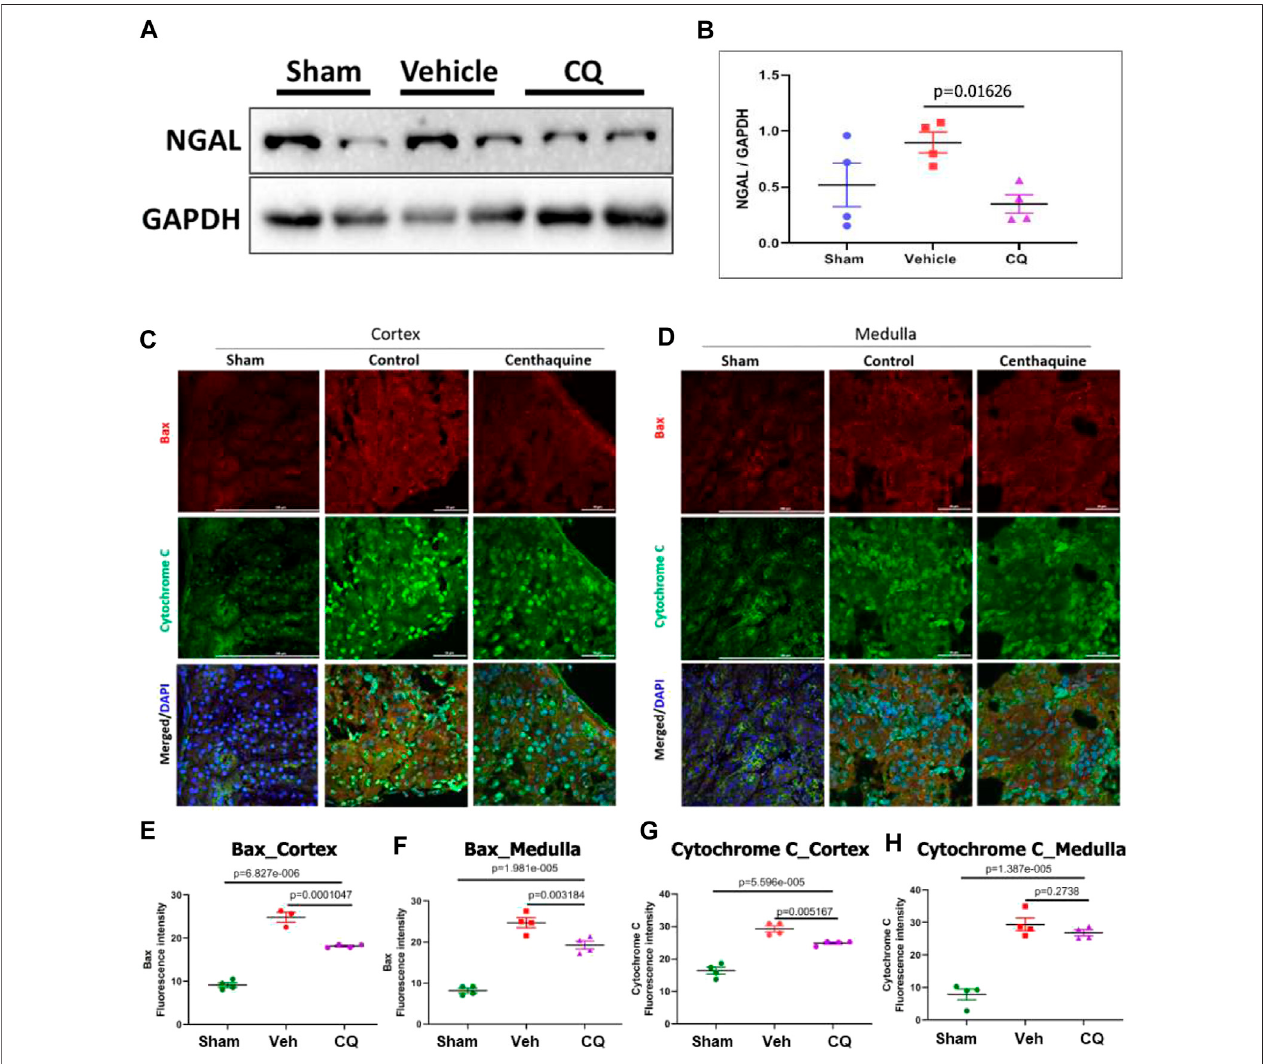
FIGURE 7 | Effect of CQ on expression of kidney damage markers. (A) , representative western blots of acute kidney damage marker, NGAL and GAPDH (loading control). Black vertical lines in A show that the bands were cropped from the same blot (full blots are provided as Supplementary Figure S3 ). (B) , graphical representation of NGAL/GAPDH normalized data. The error bar represents mean ± SEM. N (cid:1) 4. (C, D) , representative images of immuno fl uorescence of apoptotic proteins,Bax(red)andCytochromeC(green)incortex (C) andmedulla (D) insham,vehicle(control)andCQ. (E – H) ,graphsofmean fl uorescenceintensityofBaxin cortex (E) andmedulla (F) ,andofCytochromeCincortex (G) andmedulla (H) . N (cid:1) 4.Nucleiinallimmuno fl uorescencemicroscopyimageswerestainedwithDAPI(blue). Statistical analysis- Ordinary One Way ANOVA and Fisher ’ s test.